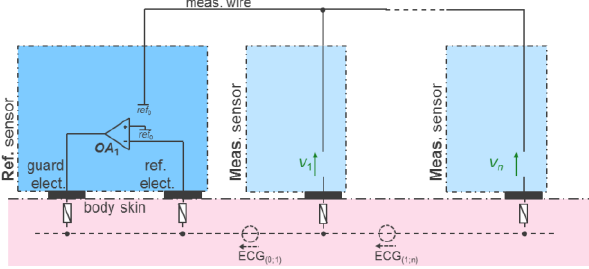
Figure 2. Cooperative-sensor architecture for measuring multilead ECG signals without centralized electronics box